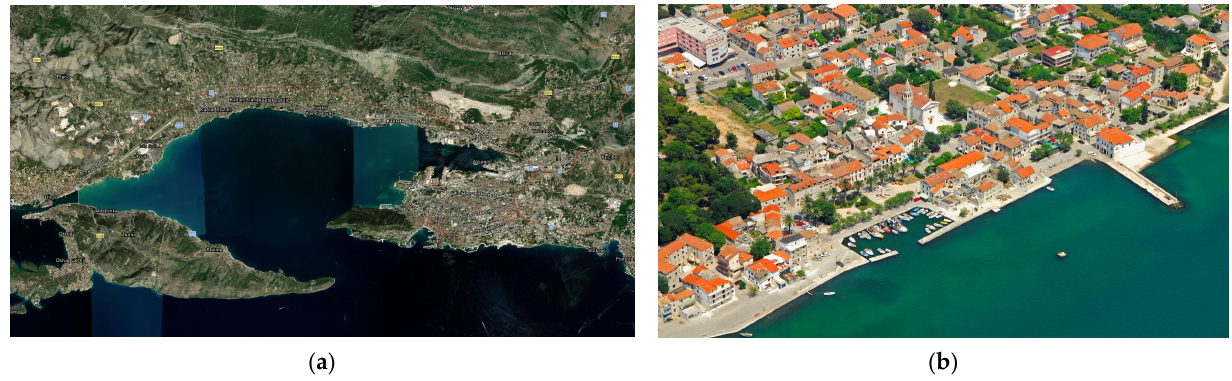
Figure 1. ( a ) Location of the city of Kaštela in Kaštela Bay; ( b ) A view of an old historical core, Kaštel Kambelovac.